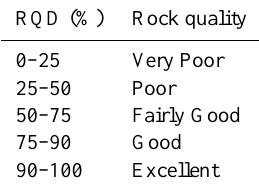
Table 1. Hard rock classification based on the quality factor RQD (modified after Leucci and De Giorgi,